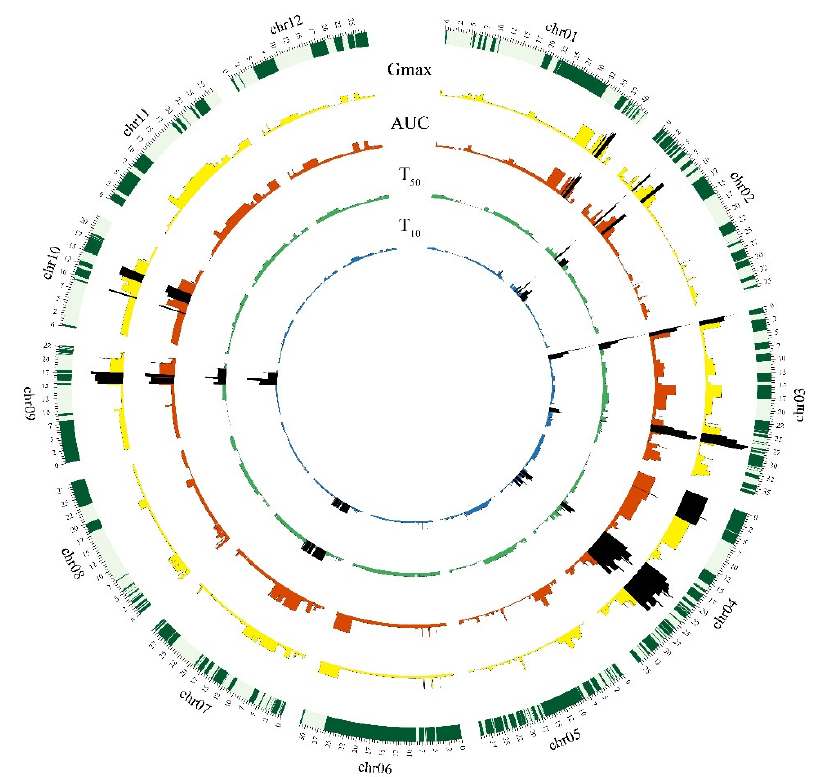
Figure 3. Histogram of Circos, four indicators for evaluating the storage quality of rice seeds. The outermost circle of the Circos diagram is the chromosome marker distribution map. The chromosomes (chr01–chr12) are arranged clockwise. Each sector bar is the size of the chromosome (Mb). The second circle is the Gmax (maximum germination percentage of seven days germination) indicator QTL distribution chart, yellow is p > 0.01, the black is p ≤ 0.01; the third circle is the AUC (area under the germination curve until 168 h) indicator QTL distribution chart, red is p > 0.01, and black is p ≤ 0.01; The fourth circle is the T50 (time to reach 50% germination of the total number of germinated seeds) index QTL distribution chart, green is p > 0.01, black is p ≤ 0.01; the fifth circle is the T10 (time to reach 10% germination of the total number of germinated seeds) index QTL distribution chart, blue is p > 0.01, and black is p ≤ 0.01. The QTL analysis is calculated by the R language ridge packet RR algorithm. Table 1. QTLs identified for four germination parameters in the NIP/ZS97 CSSL population using the single nucleotide polymorphism (SNP) bin markers.